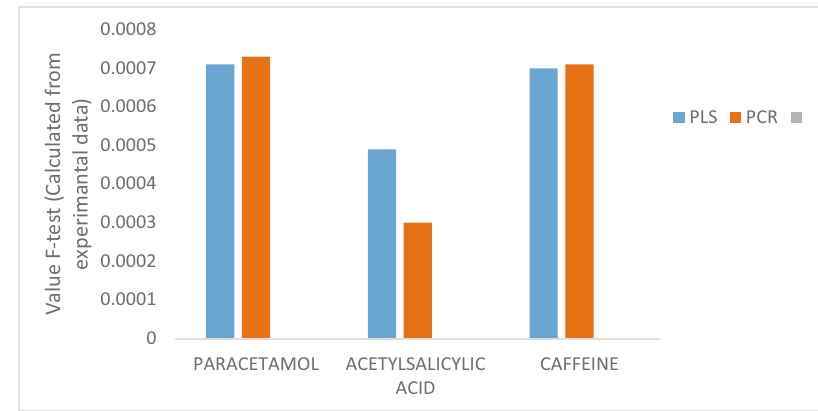
Figure 5: The results of the one - way ANOVA test accoding to Snedecor ’ s F -